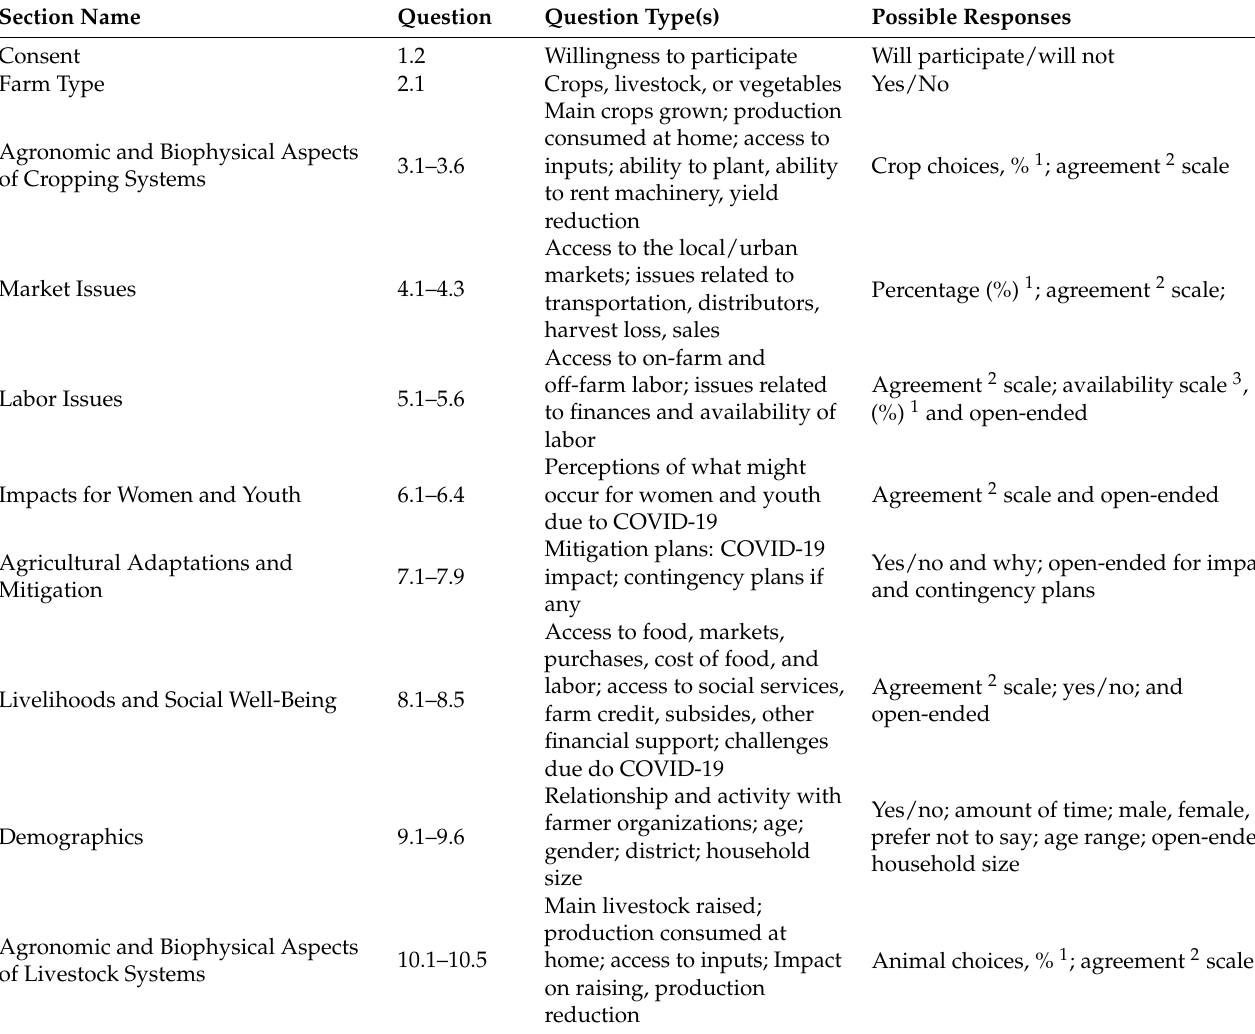
Table 1. Summary of the survey design and